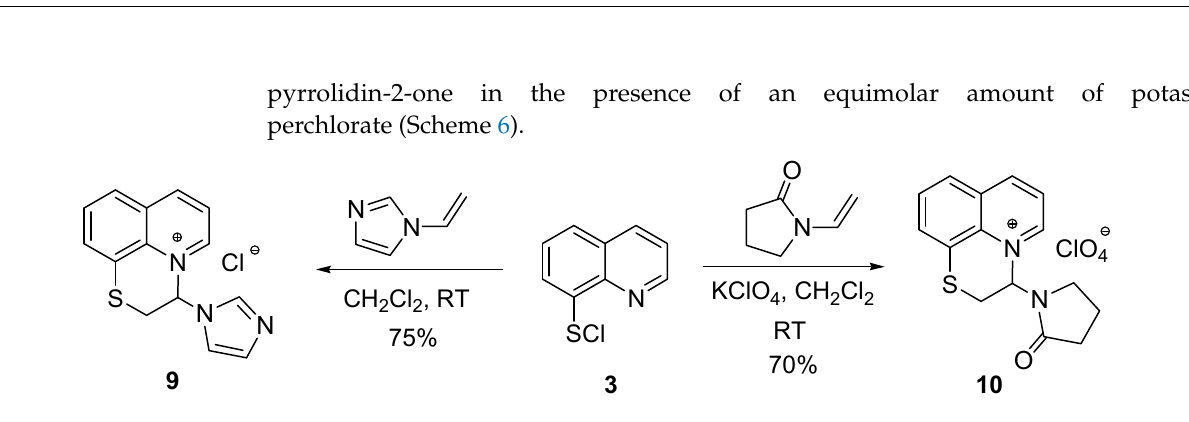
Scheme 6. Synthesis of 3-(1 H -imidazol-1-yl)-2 H ,3 H -[1,4]thiazino[2,3,4- ij ]quinolin-4-ium chloride 9 and 3-(2-oxopyrrolidin-